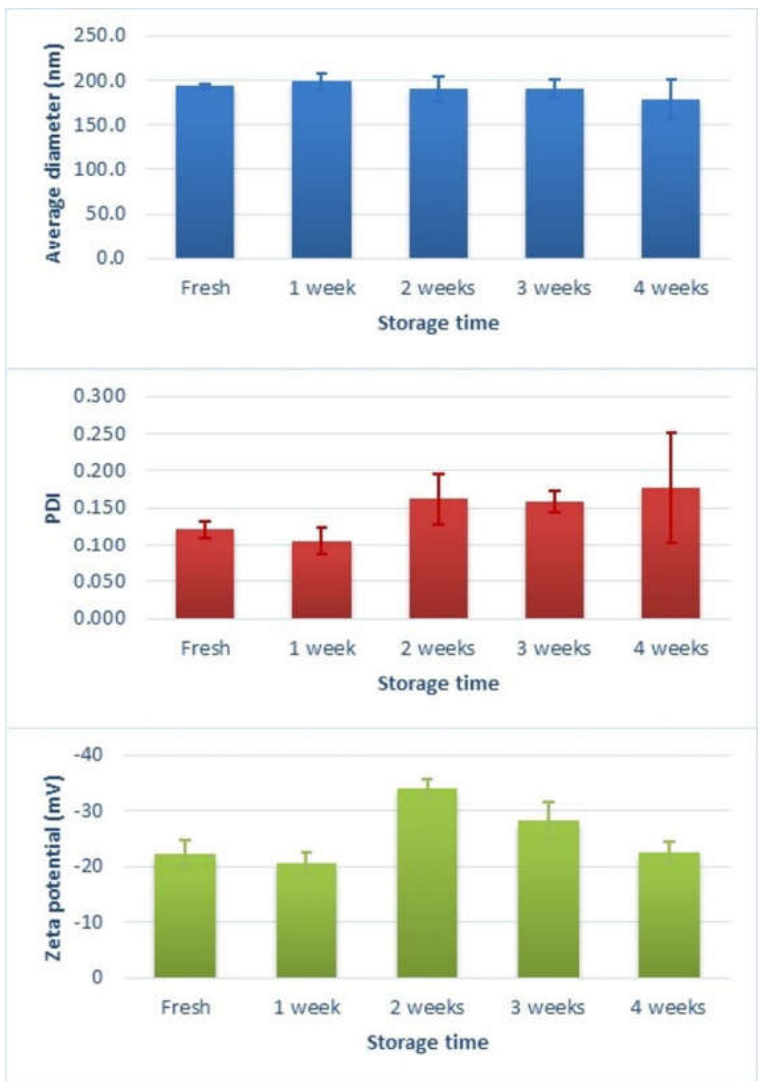
Figure 5. Variation in average hydrodynamic diameter, PDI and zeta potential of the blank polymersome dispersion in PBS (10 mM, pH 7.4) with time. The measurements were recorded from a fresh dispersion and after storage for four weeks at 4 °C.